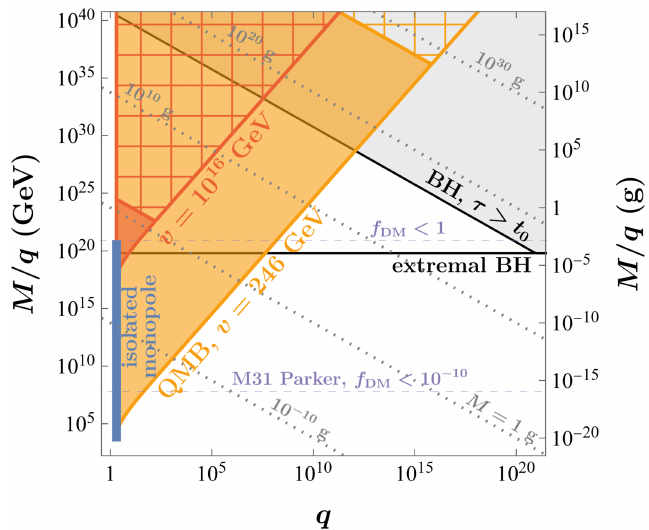
Figure 4 . Allowed mass-to-charge ratio M/q and magnetic charge q for various cosmologically stable magnetically charged states. Orange and red regions: QMBs with λ φ = 0 . 5 , λ S > 0 (in- sensitive to exact value), e 2 = 4 π/ 137 the SM value, and v = 246 (10 16 ) GeV for orange (red). The bottom-left boundaries of each region with small q and Q are not reliable because the large Q limit is assumed. Hashed regions show where the Schwarzschild radius exceeds the QMB radius, so gravitational effects (ignored here) should be taken into account. Blue vertical line: isolated monopoles with e the SM value and v varying from 246 GeV to M pl , using the same λ φ and e as the QMB. Black: magnetically charged black holes, which exist as cosmologically stable relics today either on the horizontal black line if they are extremal or in the shaded region if they are not extremal (in between, they evaporate to the extremal line with lifetime τ (cid:28) t 0 the age of the universe). Lilac horizontal dashed lines indicate the bound on the relic abundance as a fraction of the dark matter density f DM from the Parker bound applied to M31 (assuming all relics have the same charge and mass). Above the line labeled “ f DM < 1 ,” magnetically charged states could explain all of dark matter (though other model-dependent bounds exist). Gray dotted lines show contours of constant